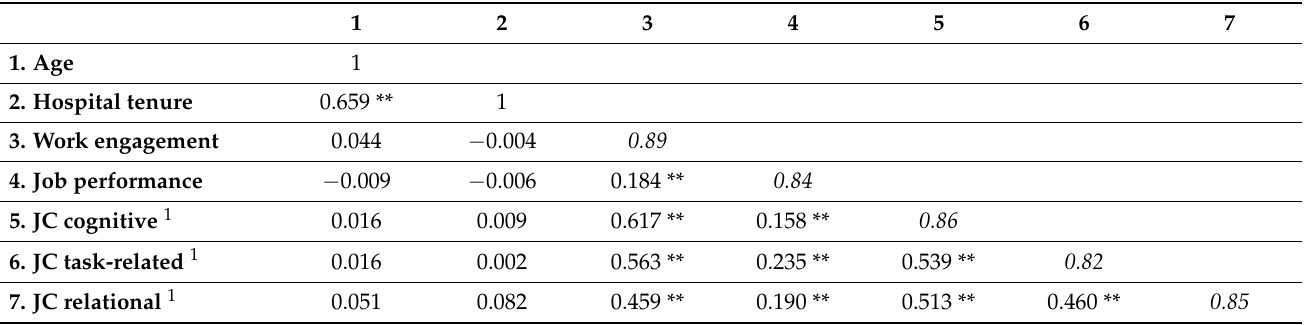
Table 4. Study 3 Pearson’s correlation matrix ( N =